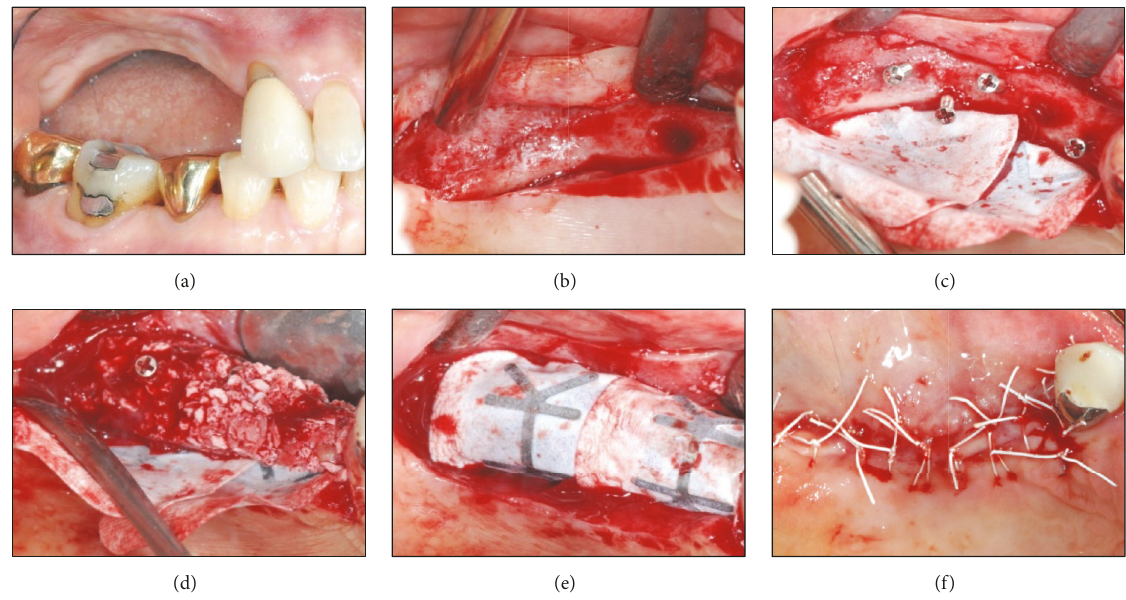
Figure 7: Vertical augmentation of alveolar ridge applied on the implant removal site. (a) Severe vertical resorption state four months after the implant removal. (b) Narrow alveolar ridge. (c) Insertion of a tenting screw (Dentium, Seoul, Korea) and application of a GORE-TEX membrane TR6Y (W. L. Gore & Associates Inc., Flagstaff, Arizona, USA). ((d) and (e)) Bone grafting using a Bio-Oss 1.0 g (Geistlich Pharma AG, Wolhusen, Switzerland), and GORE-TEX membrane covering the site and supported by the tenting screw. (f) Suture for a primary wound